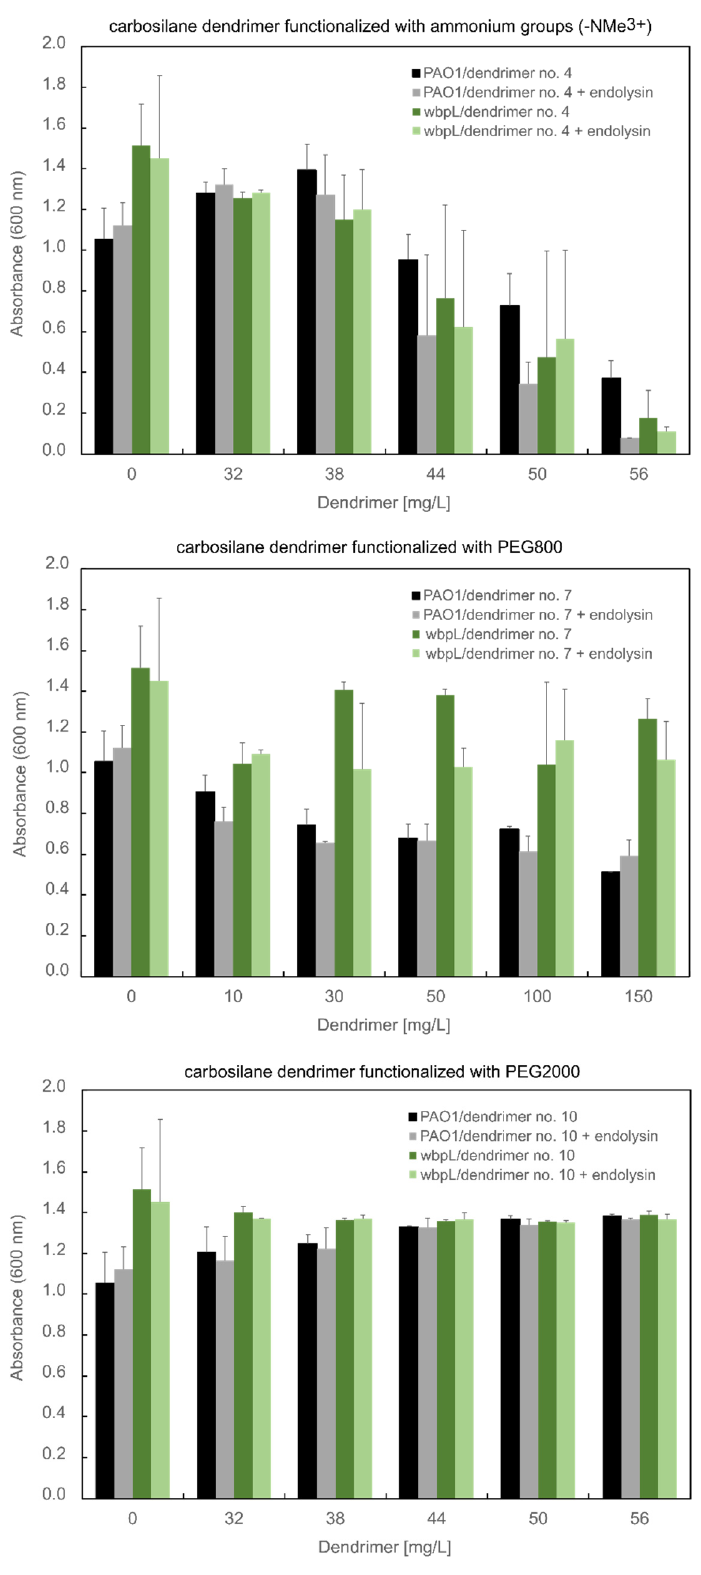
Figure 5. The optical density (OD) at 600 nm of PAO1 wild-type and its ∆ wbpL mutant after treatment with cationic dendrimers with a constant concentration of KP27 endolysin (5 mM). Results are expressed as mean ± S.D.